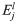
Illustration of goal-directed behavior.An example of a recent sequence of states (where Th = 1, Tf = 2) x(t − Th: t) in Ejl which shows: 1) The sequence of context inputs cjl(t-Th:t) helping to resolve uncertainty during computation of P(s); 2) A goal vector gjl(t) defining the the expected rewards of the target state. Bottom: the library of learned sequences Sjl, each sequence is defined by an ordered list of states x, each potentially in a different context cjl. Top: visualization of the current state x(t) and several possible futures. These futures are estimated based on the content of the Model. First, the probability distribution P(si) is computed based on a sequence of recent states and contexts. Then, the sequence probabilities are increased proportionally to the probability that the reward can be obtained by following that sequence (updated sequence probabilities PA(si) = Ψ(P(S)) based on the reward are depicted on the right). As a result, this increases the probability of choosing the state H as an action—setting it as a goal output Gojl(t)=H. In this example, the first 3 sequences are equally matched by the x(t − Th: t) and c(t − Th: t) therefore they have equal probabilities. But after applying the Ψ, the s0 has the smallest probability, the s1 has higher probability since it sets the δ to zero in the future, but the s2 has the highest probability, because it both: sets the δ to zero and γ to one, as required by the goal input gjl(t).